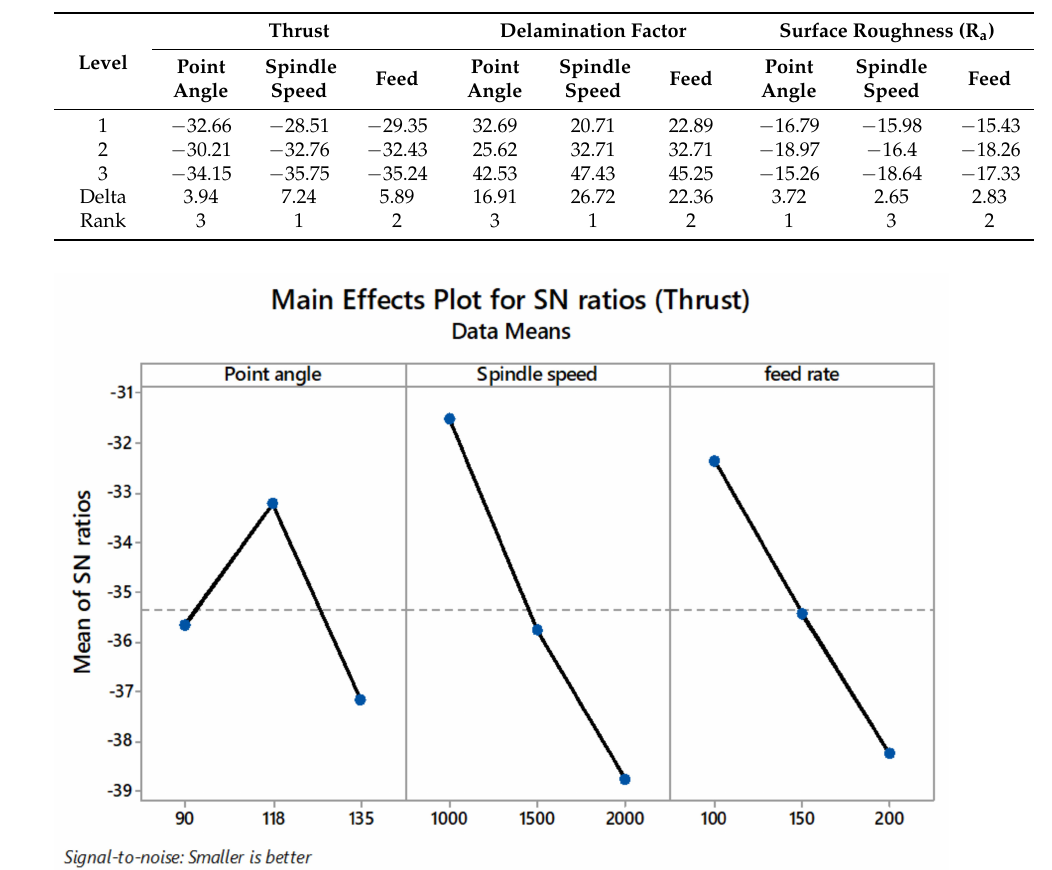
Figure 8. Main effect plot for S/N ratios of thrust force.